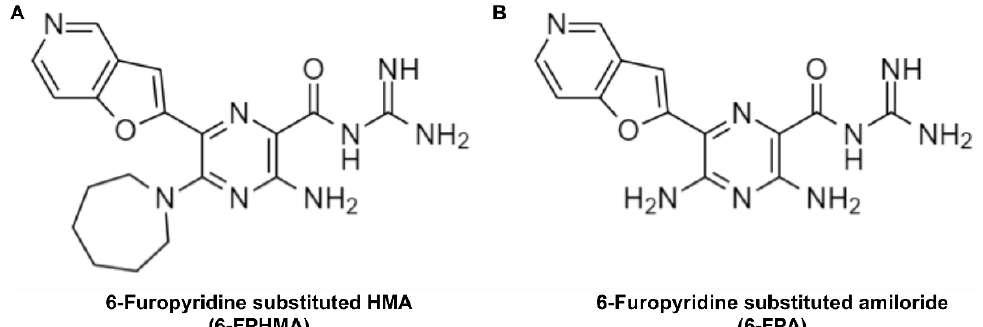
Figure 1. Chemical structures of ( A ) 6-furopyridine-substituted 5-( N , N -hexamethylene) amiloride (HMA) (6-FPHMA) and ( B ) 6-furopyridine-substituted amiloride (6-FPA). Structures were drawn with ChemDraw software v22.5.3 (PerkinElmer Informatics, Waltham, MA, USA). 3.2. 6-FPHMA, but Not 6-FPA, Inhibits hP2X7-Mediated Dye